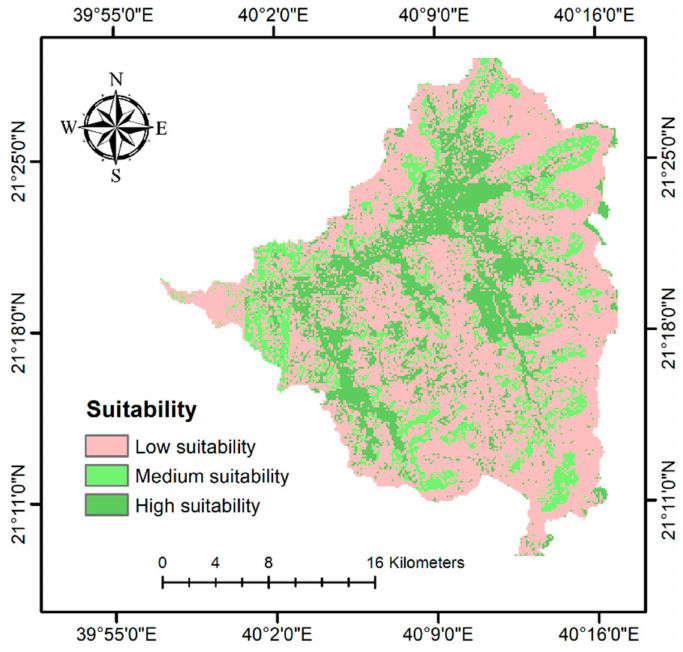
Figure 12. Map of the study area depicting RWH potential zones.